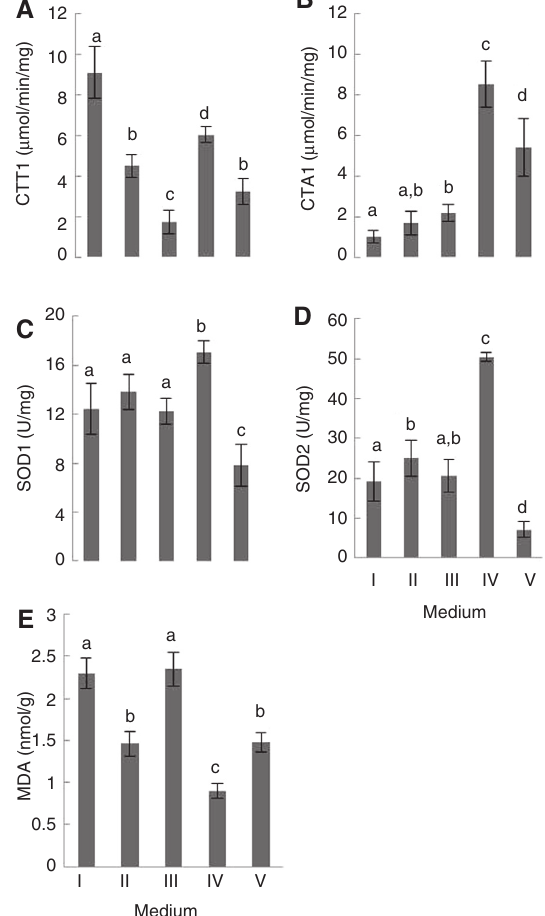
Figure 3: (A) CTT1, (B) CTA1, (C) SOD1, (D) SOD2 activity and (E) MDA level of Saccharomyces cerevisiae UE-ME medium, II- YEPGD medium, III- YEPGD medium and 5 μ g/ml TiO